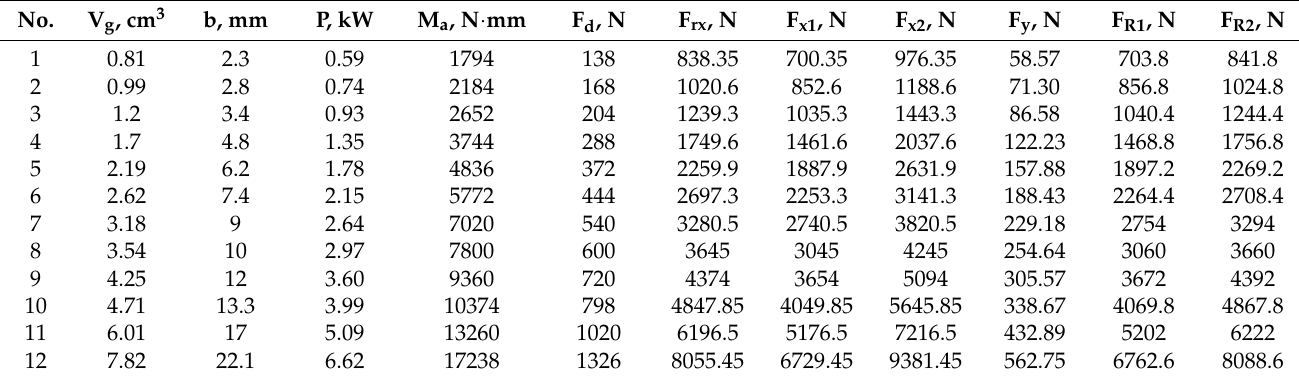
F d —the tangent component of the generated force acting on the driving gear tooth z 1 . Table 2. Calculated values of forces acting on the pump gear and